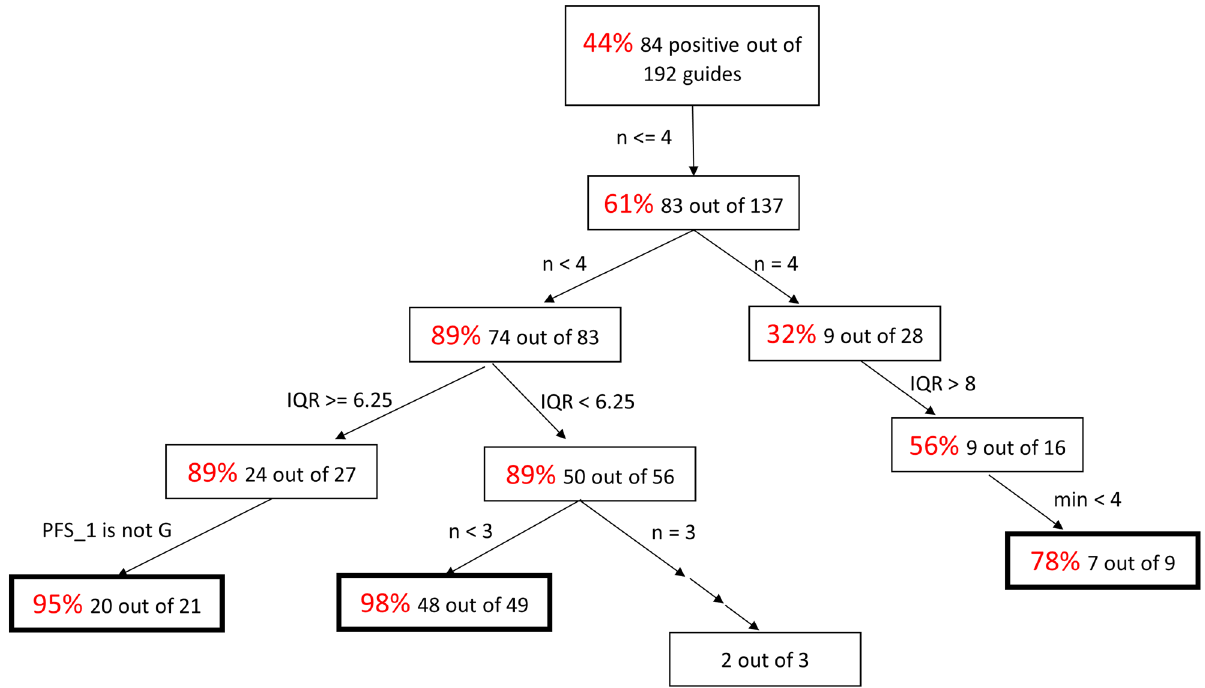
Figure 6. Maximizing guides with positive signals and recommended feature ranges (Watson–Crick). Decision tree for maximizing the number of guides with positive signals. Percentage of positive guides for each set of conditions is highlighted in red. Using the rules output by the RuleFit classifier, conditional control statements were used to filter the initial 84 positive guides from the total set of 192. The features used are n, IQR, min, and PFS_1. Linearized, the decision rules for maximizing positive signals in our set of guides are 1) if IQR is ≥ 6.25, n is between 0 to 3 and pfs_1 is A, U, or C, 2) if IQR is < 6.25, n is between, 0 to 2, and 3) if n = 4, IQR is between 9 and 28 and min is between 1 and 3. These rules achieve 95% positive guides from an initial pool that is 44% positive, including guides with up to four